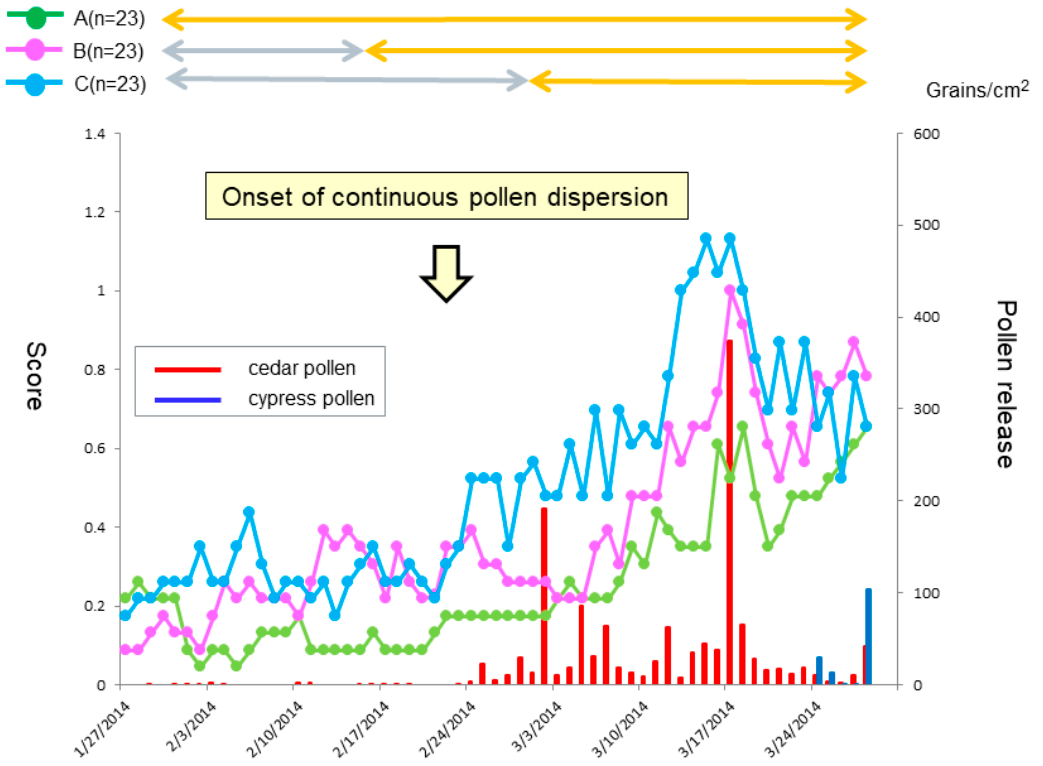
Figure 4. Daily scores reflective of quality of life (QOL) score from baseline. The lines, symbols and bars are explained in Figure 1.